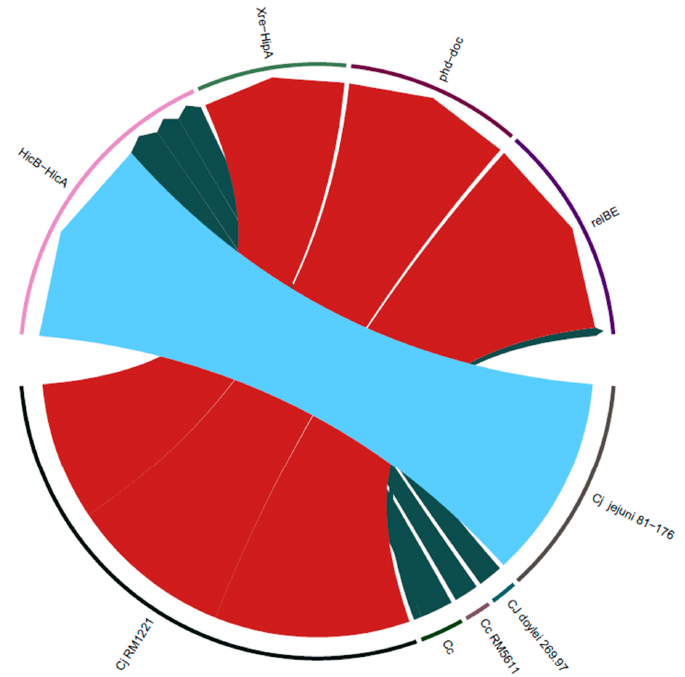
Figure 2. Circos plot showing the distribution of type II TA families from different strains. The lower nodes correspond to different genomic strains from which arcs are drawn towards the corresponding TA families in the upper nodes. The thickness of each arc corresponds to the number of isolates containing TA systems that belong to a given TA family and are matched from a given strain. C.j, Campylobacter jejuni and C.c, Campylobacter coli.